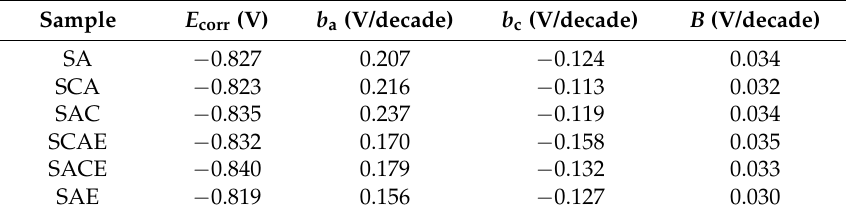
Figure 1. Tafel plots of the studied samples in the deaerated solution. Table 2. Average kinetic values of the different AA6012 samples obtained from Tafel plots in deaerated solution.